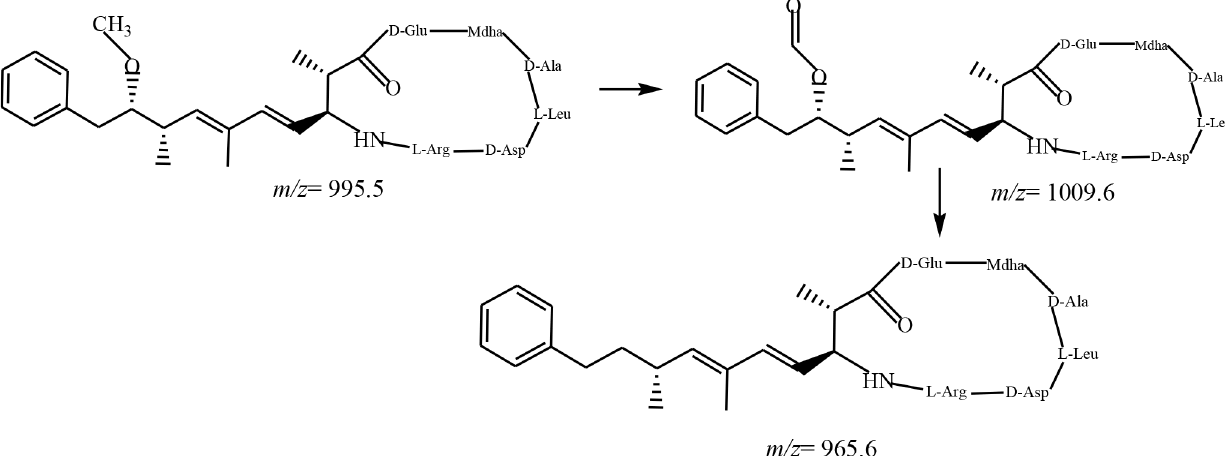
Fig 4. Byproducts and proposed reaction pathways for the combined UV/H2O2 degradation of the methoxy group of Adda of